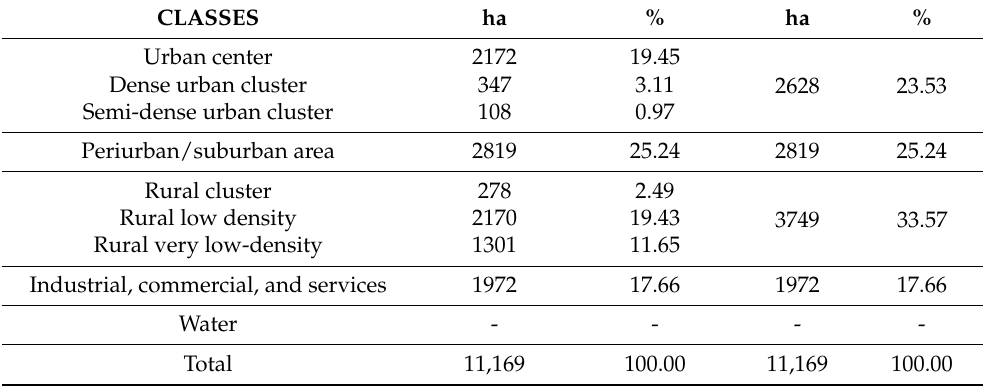
Table 7. Distribution of land consumption (2012–2018) among the different urban–rural